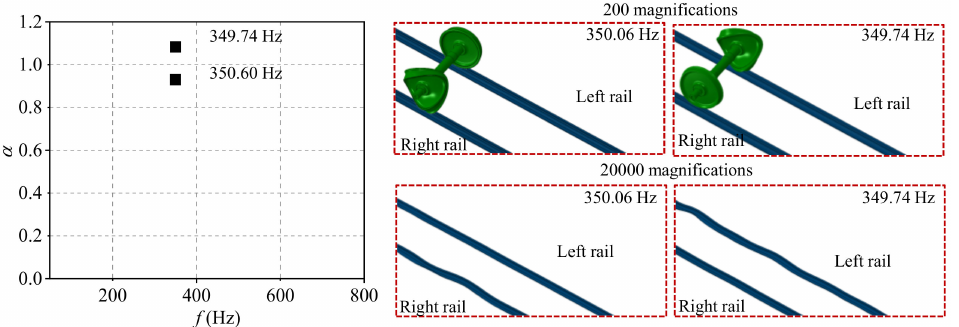
Figure 10. Distribution of real parts of eigenvalues and modal situations of the polygonal wheel– corrugated rail